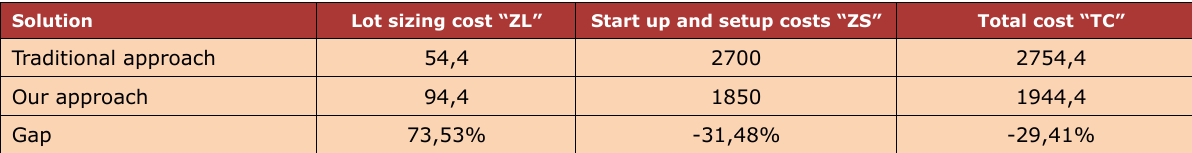
Table 1. Comparing the New approach with the Traditional